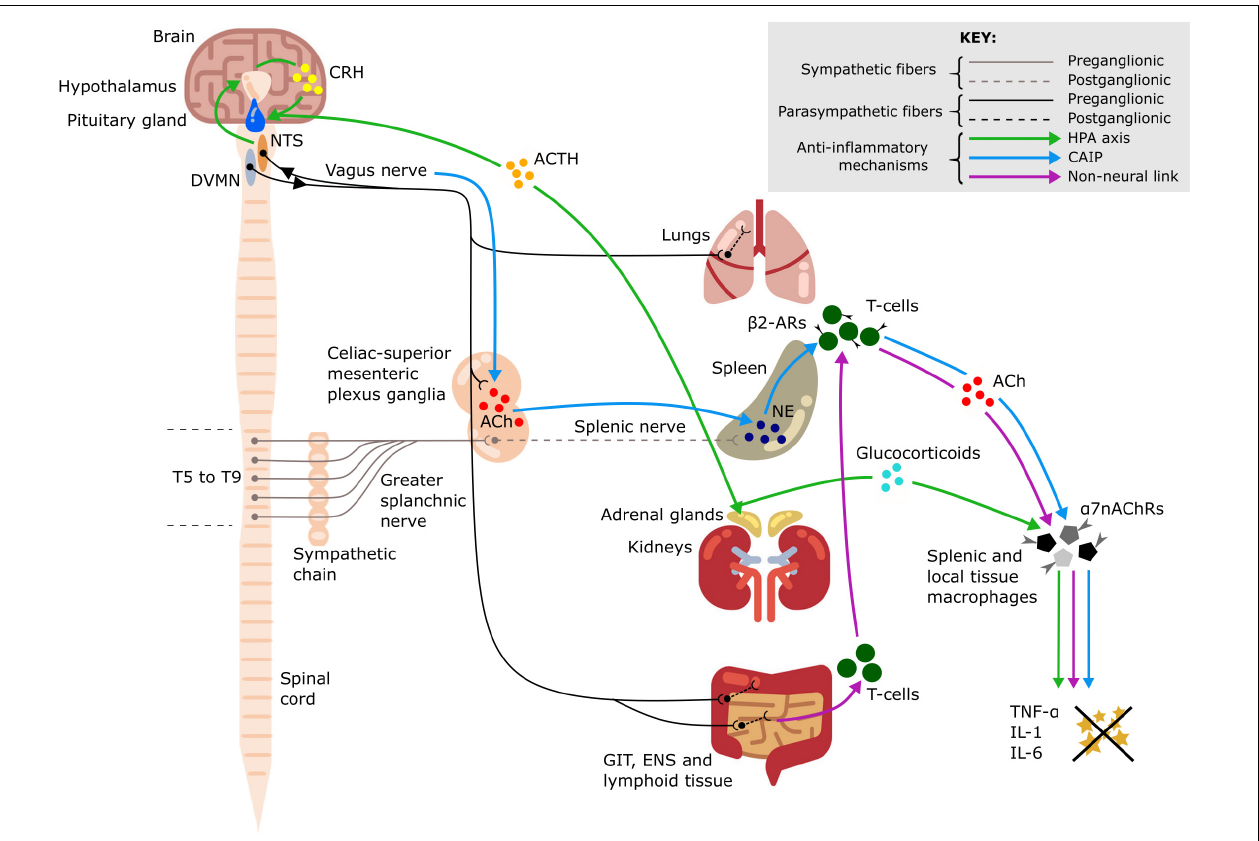
FIGURE 1 | Anti-inflammatory pathways of the vagus nerve. A schematic representation of the anti-inflammatory pathways of the vagus nerve including the hypothalamic-pituitary-adrenal (HPA) axis (green arrows), the cholinergic anti-inflammatory pathway (CAIP) (blue arrows) and the non-neural link between the vagus nerve and spleen (purple arrows). All three pathways result in attenuation of pro-inflammatory cytokine production, including tumor necrosis factor- α (TNF- α ), interleukin-1 (IL-1), and interleukin-6 (IL-6). Dorsal motor nucleus of the vagus nerve (DVMN), nucleus of the solitary tract (NTS), gastrointestinal tract (GIT), enteric nervous system (ENS), thoracic vertebrae (T5–T9), acetylcholine (ACh), NE (norepinephrine), corticotropin-releasing hormone (CRH), adrenocorticotrophic hormone (ACTH), β 2-adrenergic receptors ( β 2-ARs), and α 7–nicotinic ACh receptors ( α 7nAChRs).